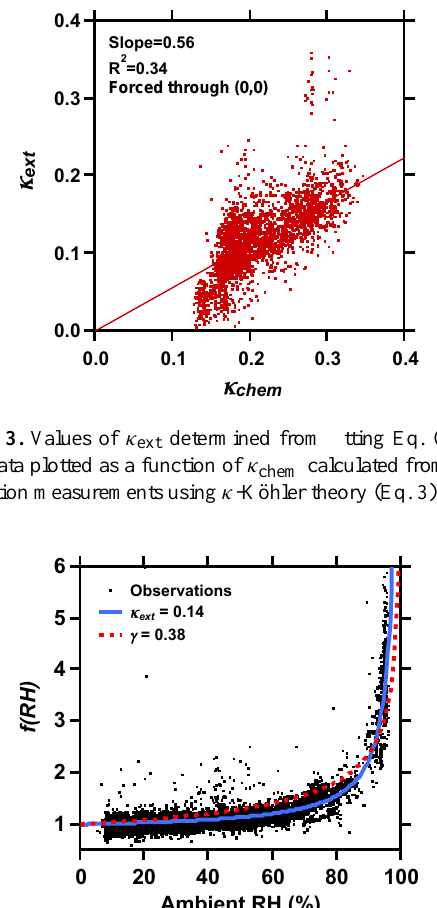
Figure A4. Values of f (RH) from rooftop measurements of am- bient and dry extinction made at Boulder, Colorado, US, from 5 March to 6 April 2015. Curves are two-sided least-squares fits to the data using the κ ext and γ parameterizations. Data are selected for periods when κ chem determined from measurements made with the C-ToF-AMS were <